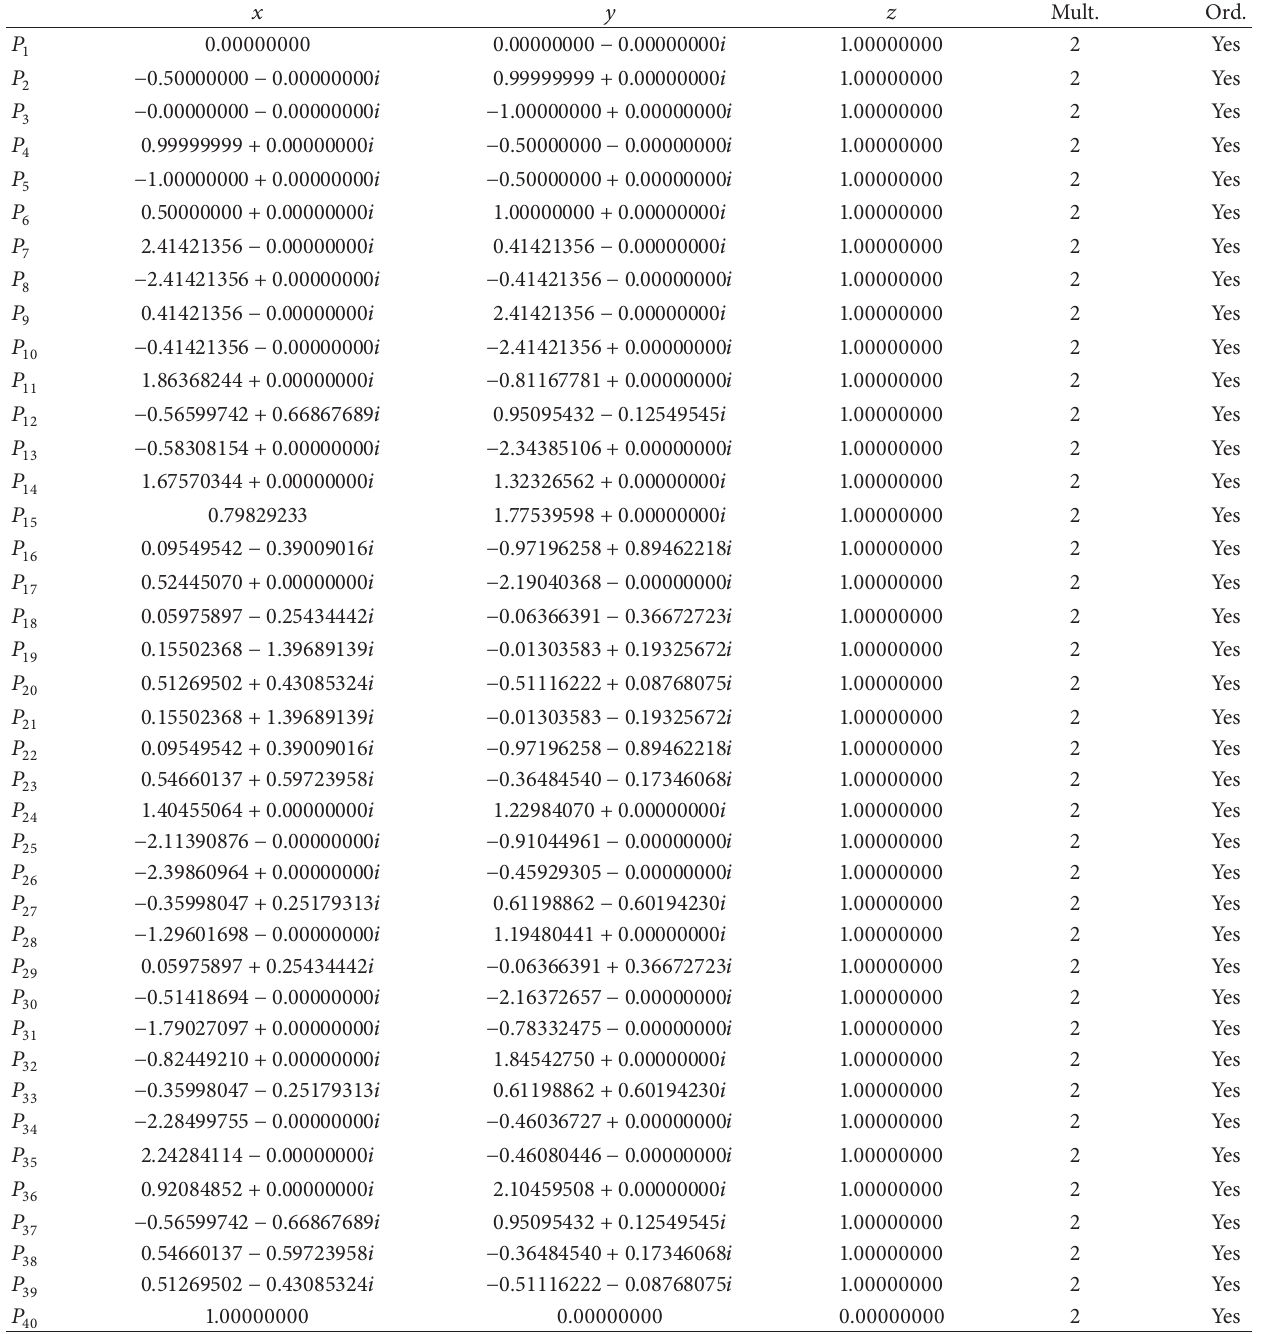
Table 2: Results for 𝑓(𝑥,𝑦) = 0 in Example